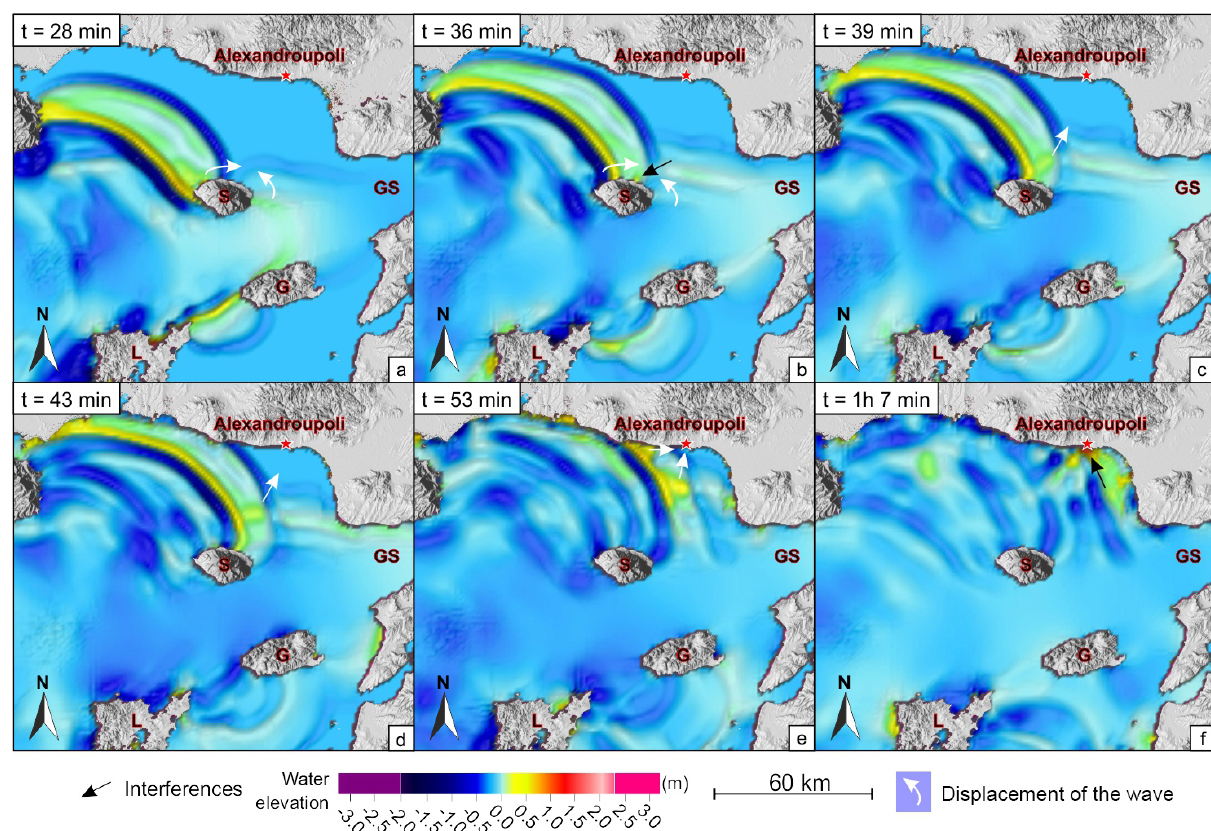
Figure 6. Tsunami propagation in the NE of the Aegean Sea: illustration of a complex system of amplification by interference for the first credible scenario (Table 1). GS is Gulf of Saros, G is Gokceada, L is Lemnos, OG is Gulf of Orfani and S is Samothrace. (a) The arrival in the south of Samothrace of wavefront, (b) rotation of the wavefront around Samothrace and development of constructive interferences in the north of the island, (c) recess of the wavefront of the island, (d) migration to the north for the new wavefront, (e) arrival of another front by the west, (f) constructive interferences in front of Alexandroupoli and formation of a wave of 1 . 65m